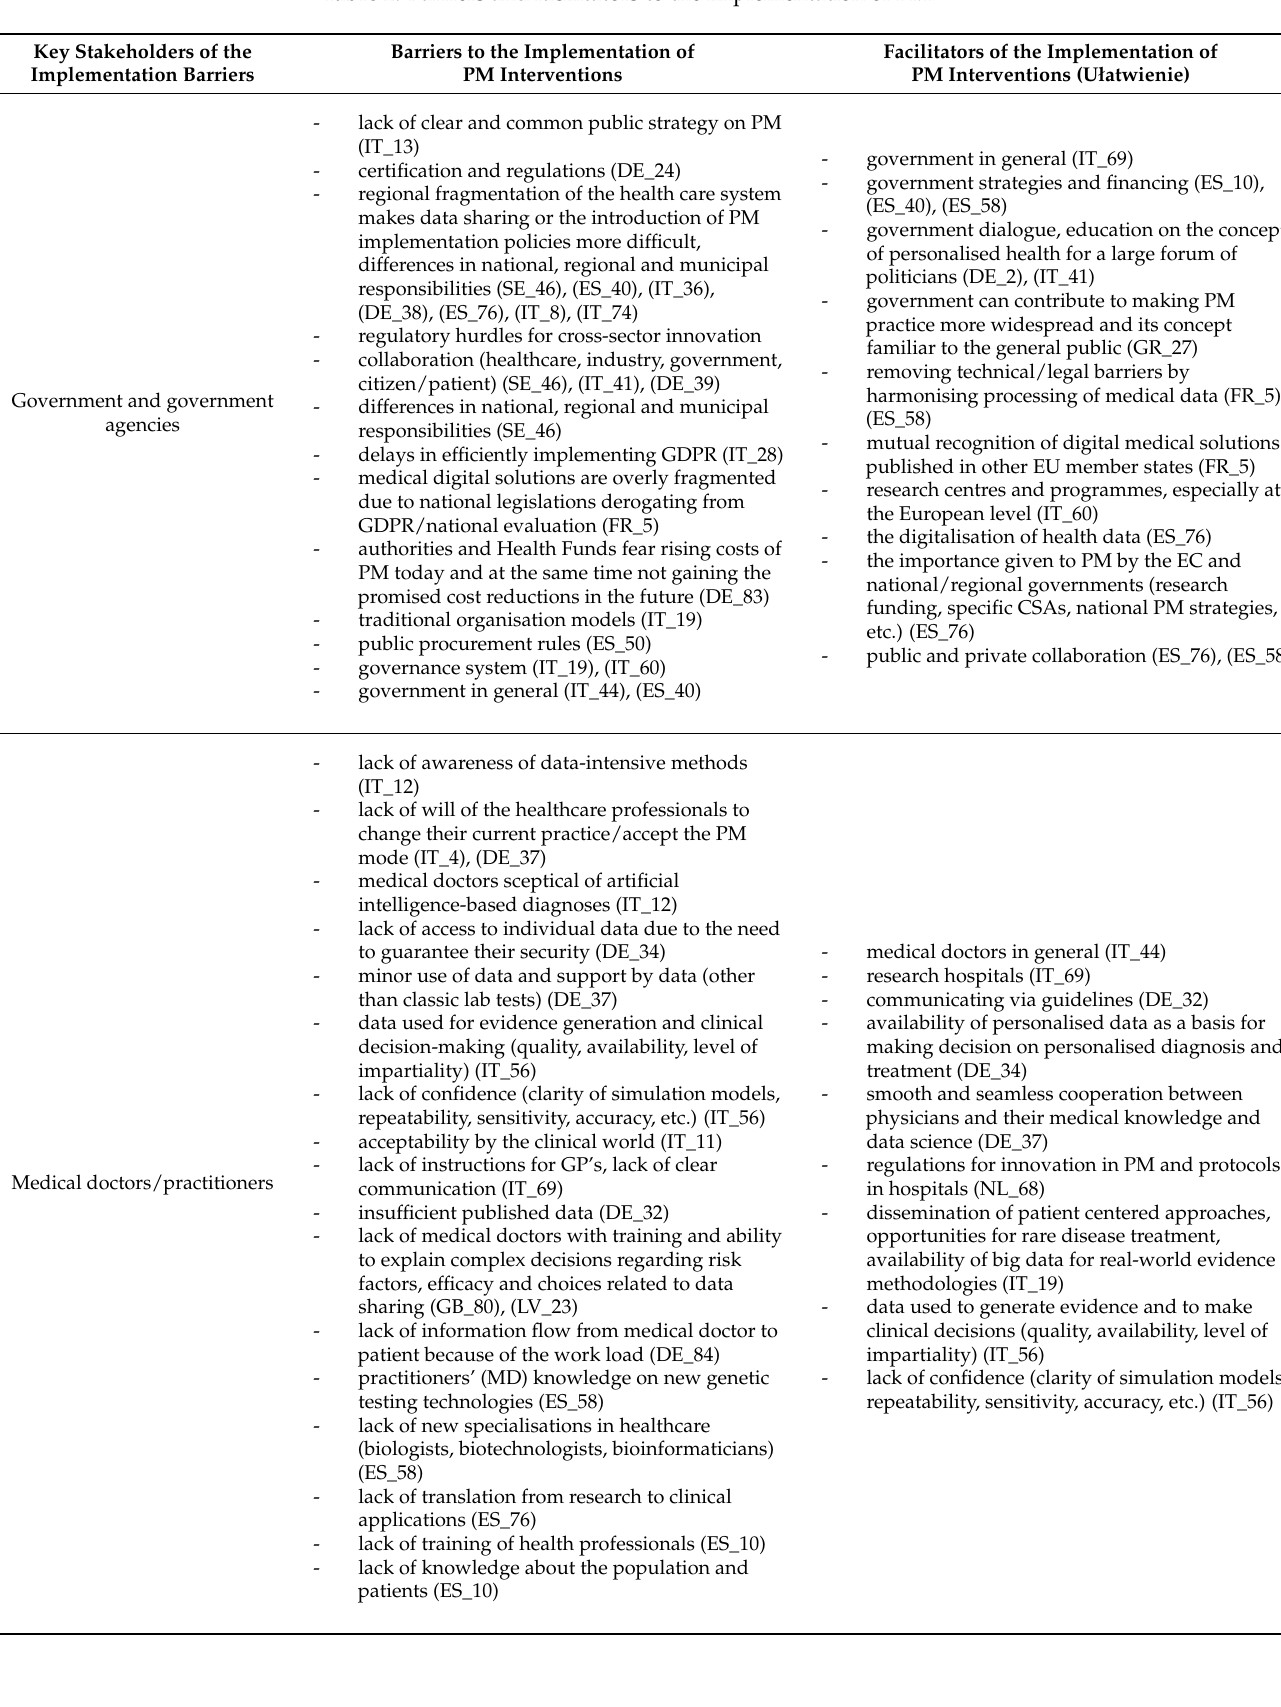
Table 2. Barriers and facilitators to the implementation of